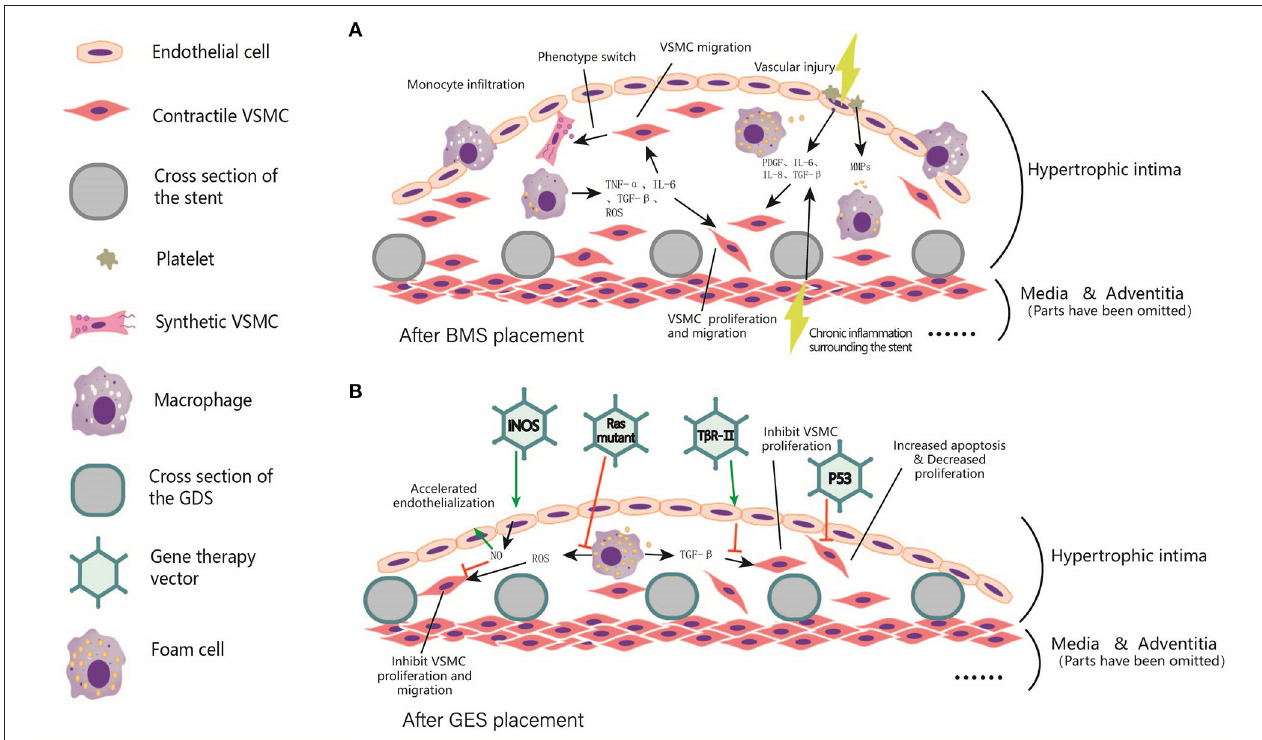
FIGURE 3 | Local intimal hyperplasia in arterial lumen after BMS and GES implantation. (A) Before stent implantation, A balloon is usually used to predilate the stenosis segment of the artery, resulting in local damage to the intima. In addition, chronic inflammation occurs surrounding the stents. Subsequently, platelet aggregation, invasion of inflammatory cells, and cause the release of TNF- α , PDGF, IL-6, IL-8, TGF- β , ROS, and other inflammatory mediators were observed. These factors trigger VSMCs proliferation, and even foam cells formation. (B) After the coating was added to the scaffold skeleton, vectors were loaded to the coating for delivering the target gene to local endothelial cells, smooth muscle cells, fibroblasts and macrophages, etc. These target genes include iNOS, p53, Ras Mutant and T β R-II, etc. In general, the expression of target genes can inhibit the excessive proliferation of smooth muscle cells, reduce the generation of extracellular matrix, and accelerate endothelialization, thus reducing the process of in-stent restenosis and the occurrence of in-stent